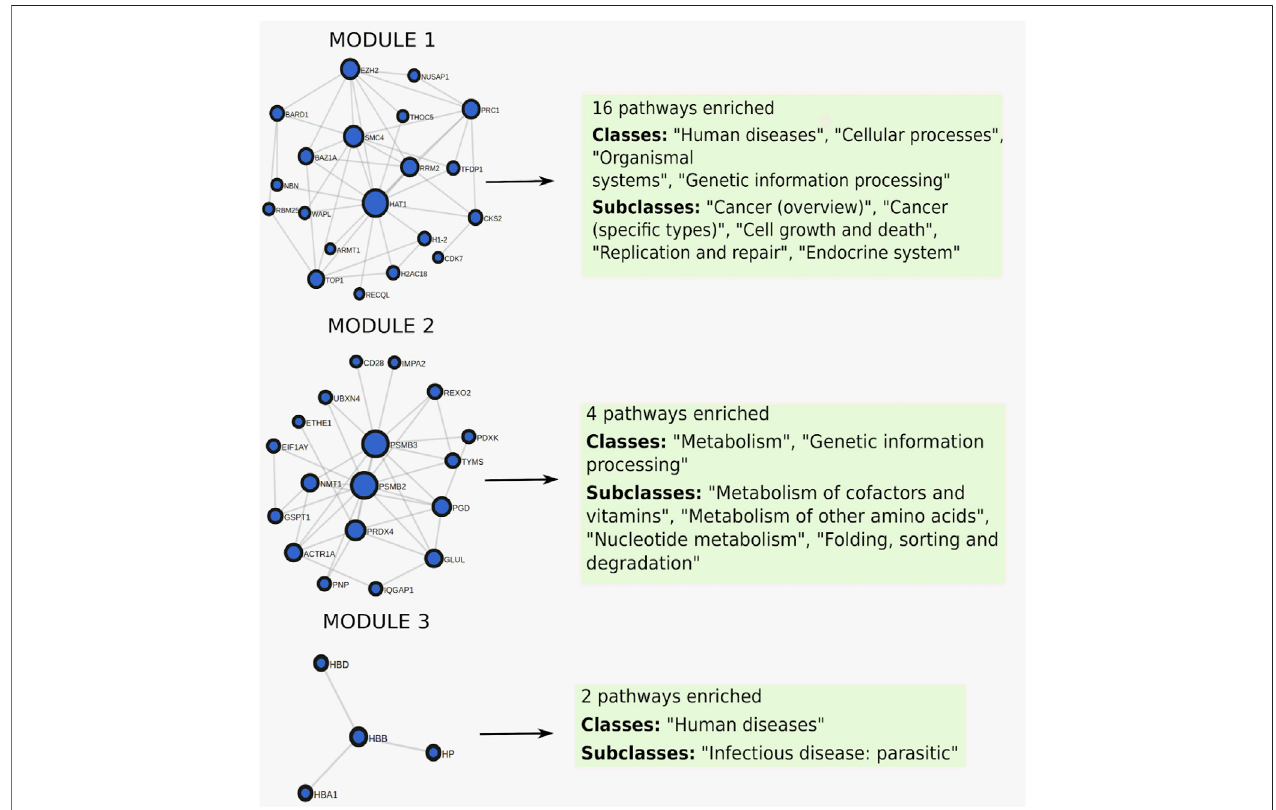
FIGURE 6 | Clustered pathway enrichment analysis of the MSigDB gene set HAHTOLA_SEZARY_SYNDROM_UP. The gene set is divided into 3 modules by applying the network clustering algorithm Infomap. Each module fi nds different classes of pathways.